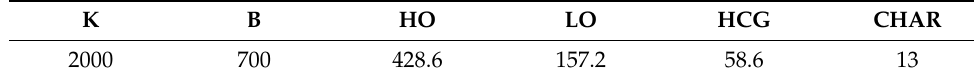
Table 4. Molecular weights of pseudo-components (in